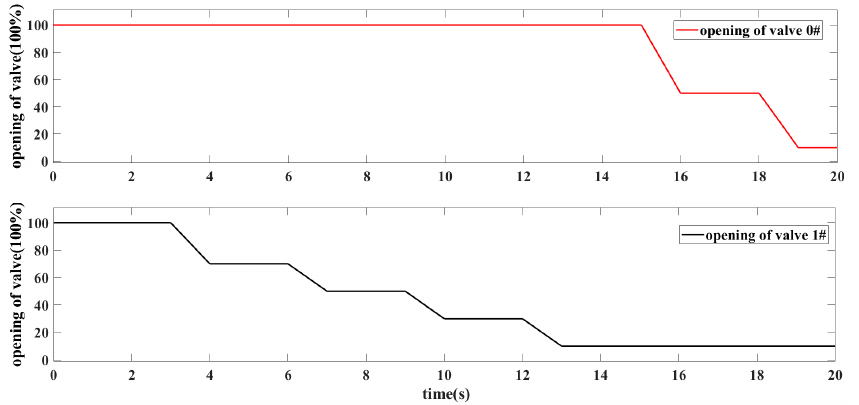
Figure 14. Opening of two valves of the compression system.